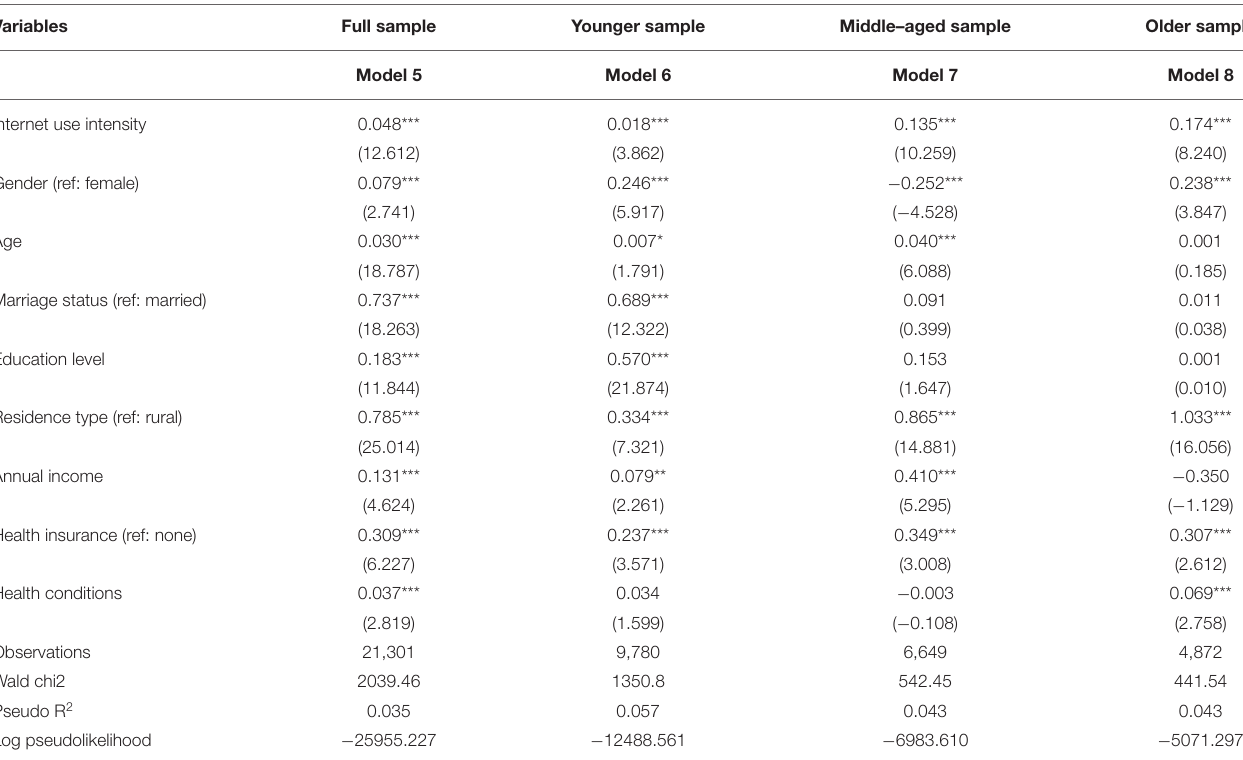
TABLE 4 | Results of the relationship between internet use intensity and physical exercise ( N =